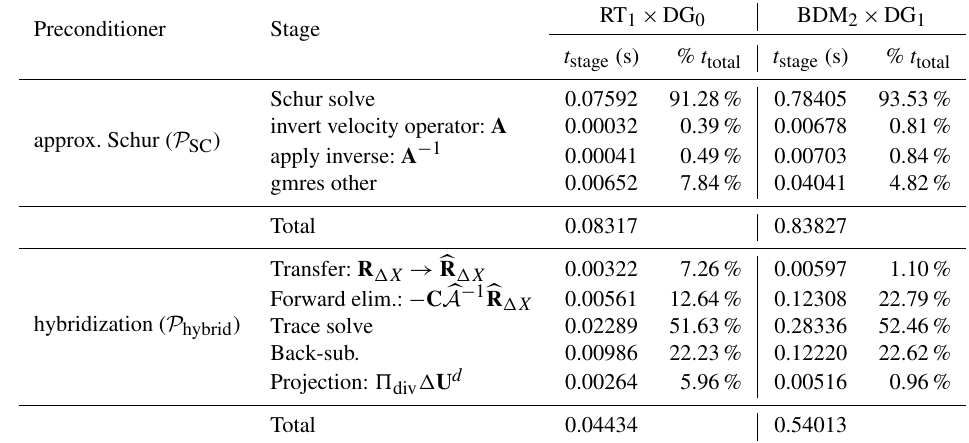
Table 4. Breakdown of the cost (average) of a single application of the preconditioned flexible GMRES method and hybridization precondi- tioner. Hybridization takes approximately the same time per